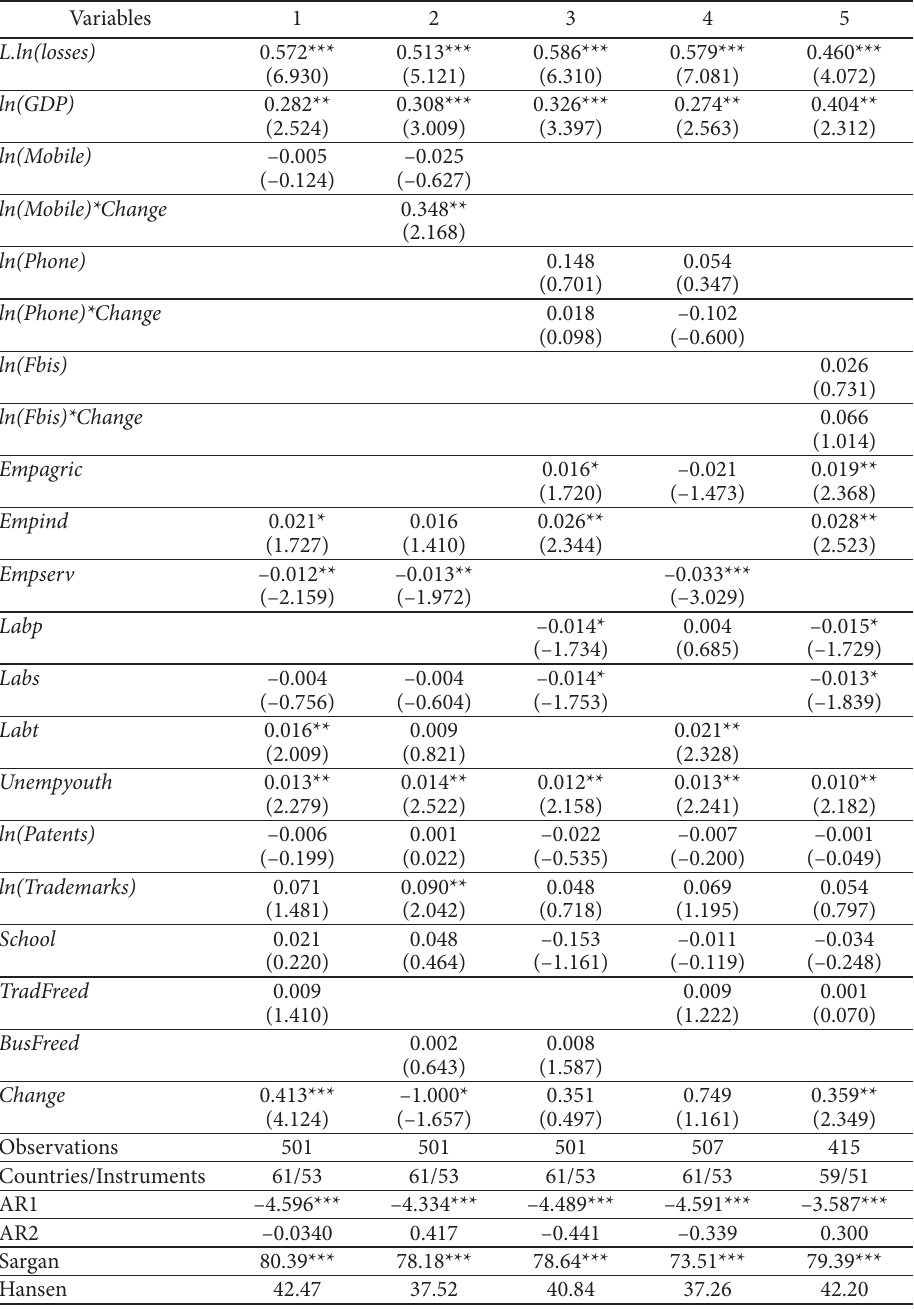
Table 2. Dynamic model using one-step System